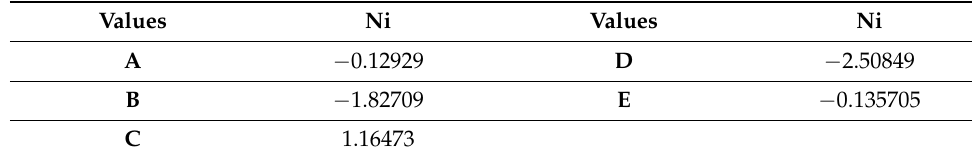
Table 1. The values of model for the Ni